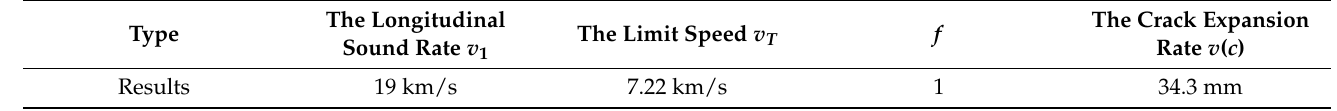
Table 4. The calculation results of the walnut crack expansion